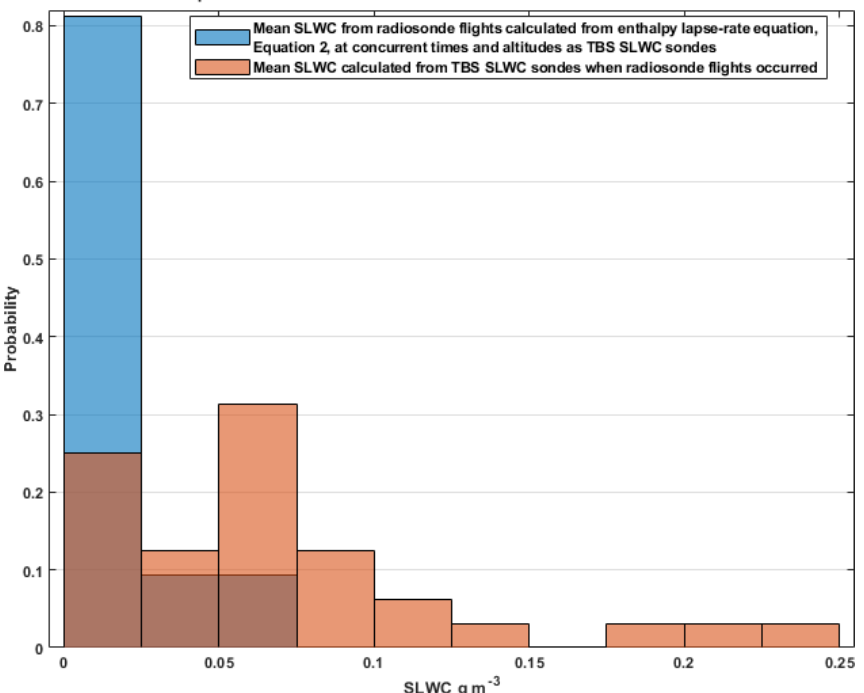
Figure 11. The 2016–2017 Mean SLWC from Anasphere sondes (orange) and mean SLWC calculated from AMF3 radiosonde flights (blue) during TBS flights over the TBS flight altitude range.